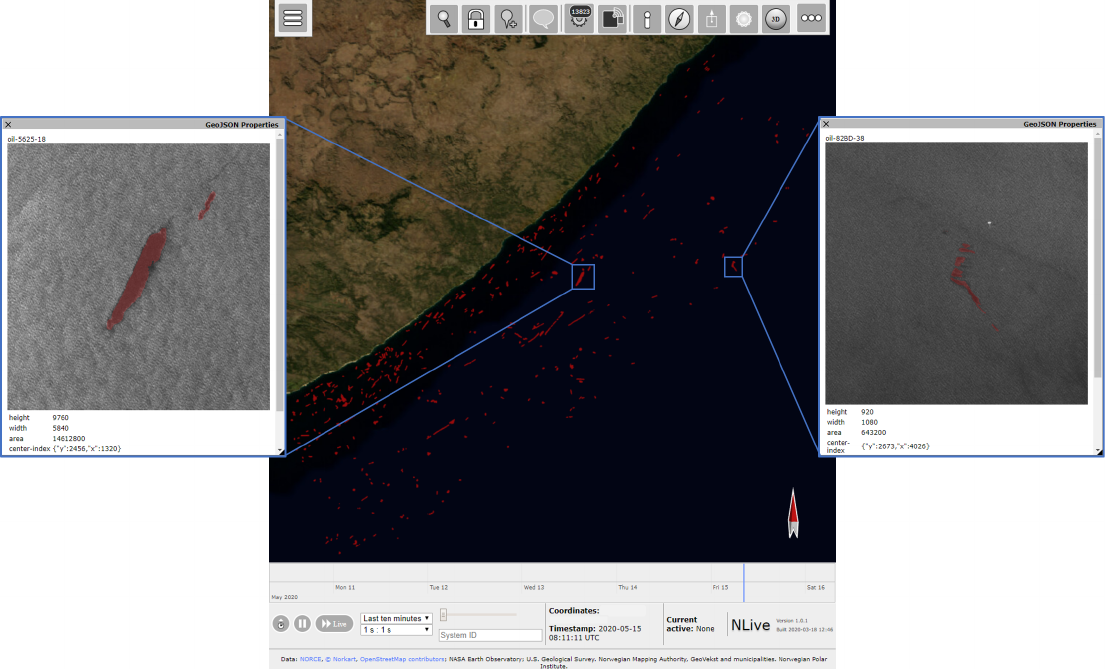
Figure 12. Visualization in NLive of oil spills detected in a large area (approximately 500 × 200 km 2 ) in the South hemisphere between 2014 and